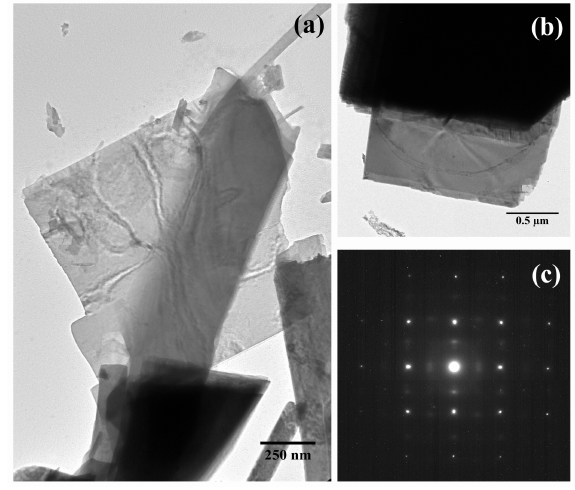
Figure 5. ( a , b ) TEM micrographs of the α -MoO 3 nanoplates; ( c ) SAED pattern.